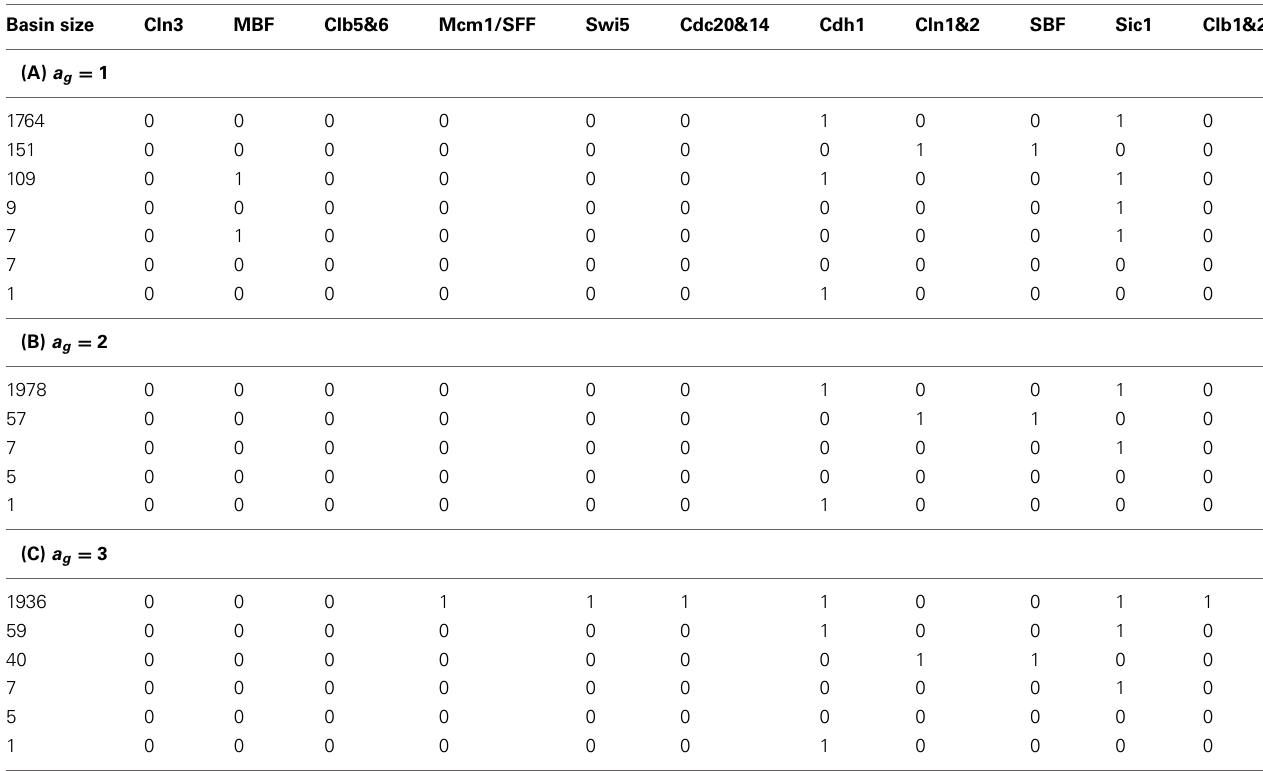
Table 1 | The attractor set for the cell-cycle threshold Boolean network under different interaction coefficients. Basin size